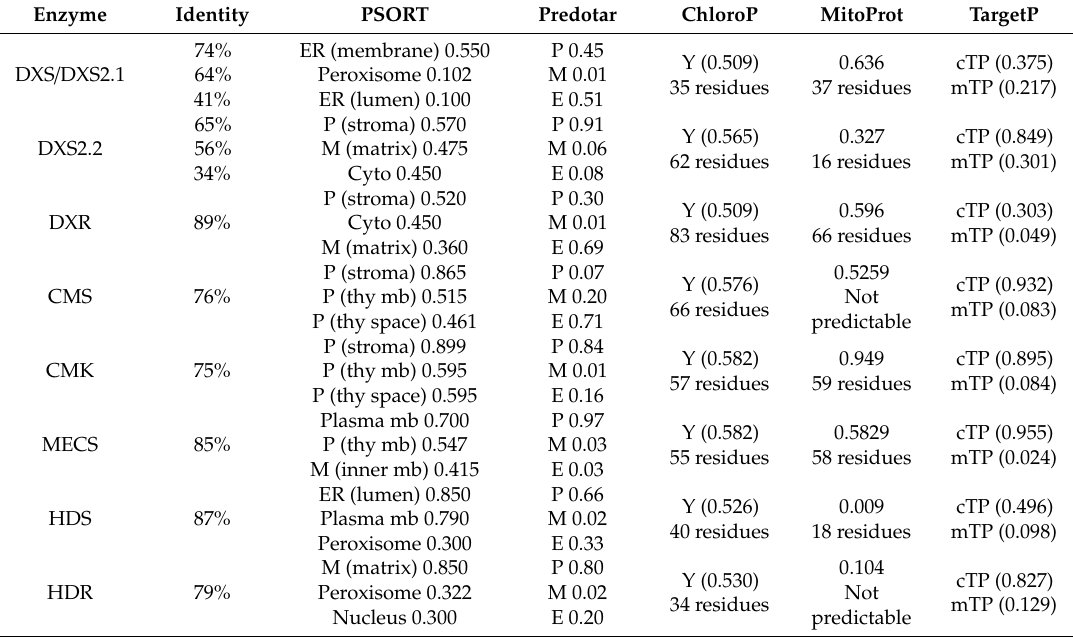
Table 1. Identity of the C. roseus MEP pathway enzymes excluding transit peptides with the corresponding A. thaliana orthologs and prediction of subcellular localization of the full sequences. Enzyme Identity PSORT Predotar ChloroP MitoProt TargetP DXS /